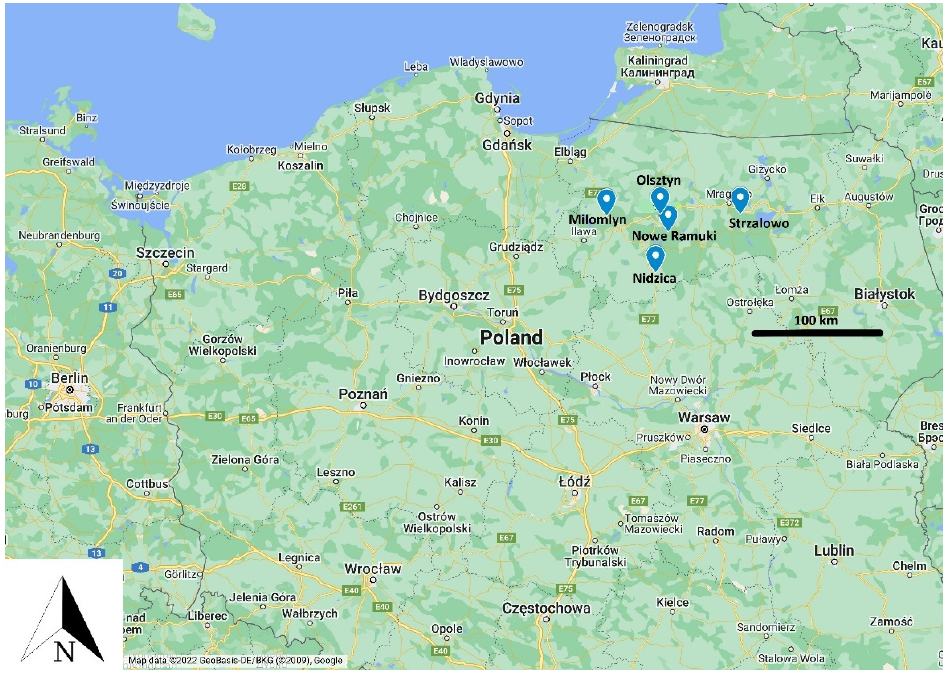
Figure 1. Four hunting districts are located in north-eastern Poland. The black bar indicates 100 km distance (Map data, Google, 2022).